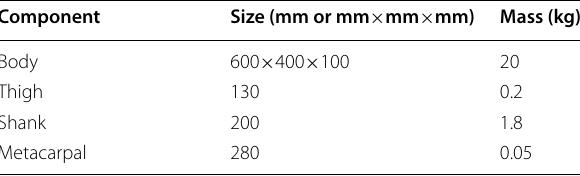
Table 3 Basic parameters of the quadruped robot elements Component